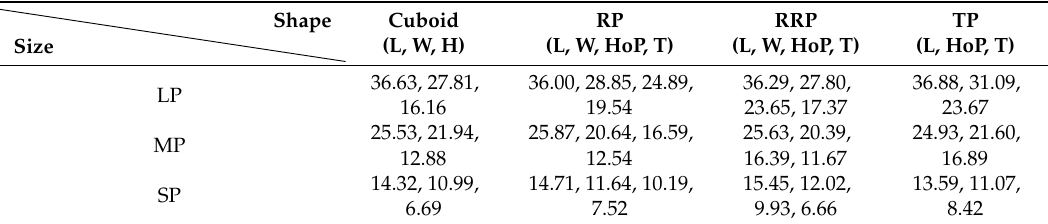
Table 2. Mean size table of pig manure (unit: mm).